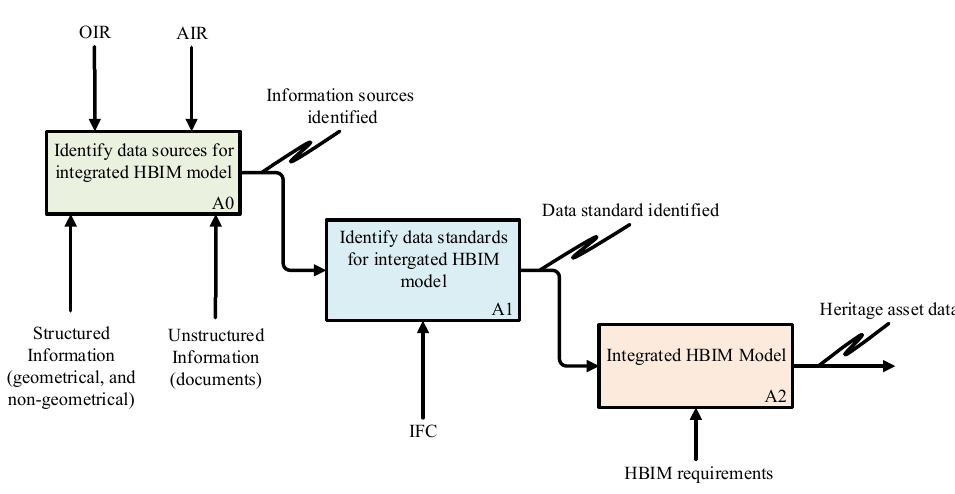
Figure 6. IDEF0 diagram for identification of information sources.